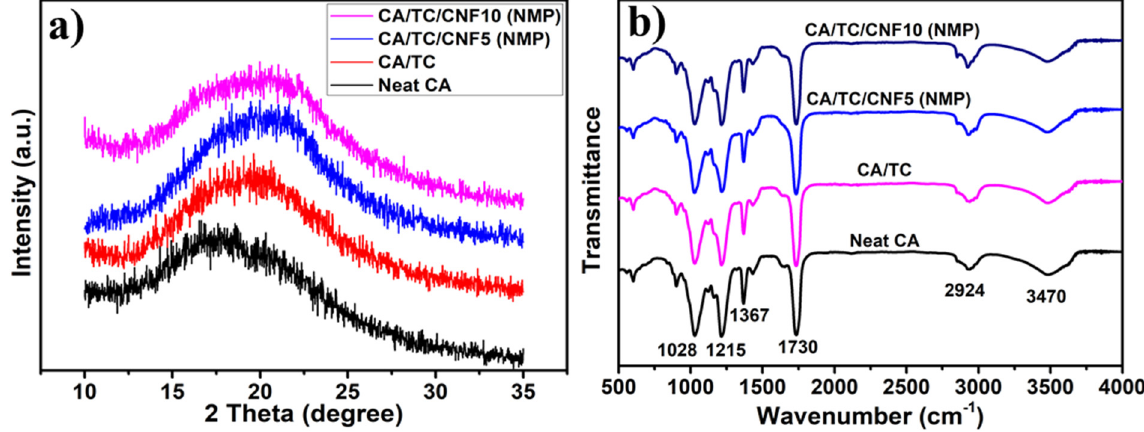
Figure 10. XRD patterns ( a ) and FTIR spectra ( b ) of Neat CA, CA/TC, CA/TC/CNF5 (NMP) and CA/TC/CNF10 (NMP).